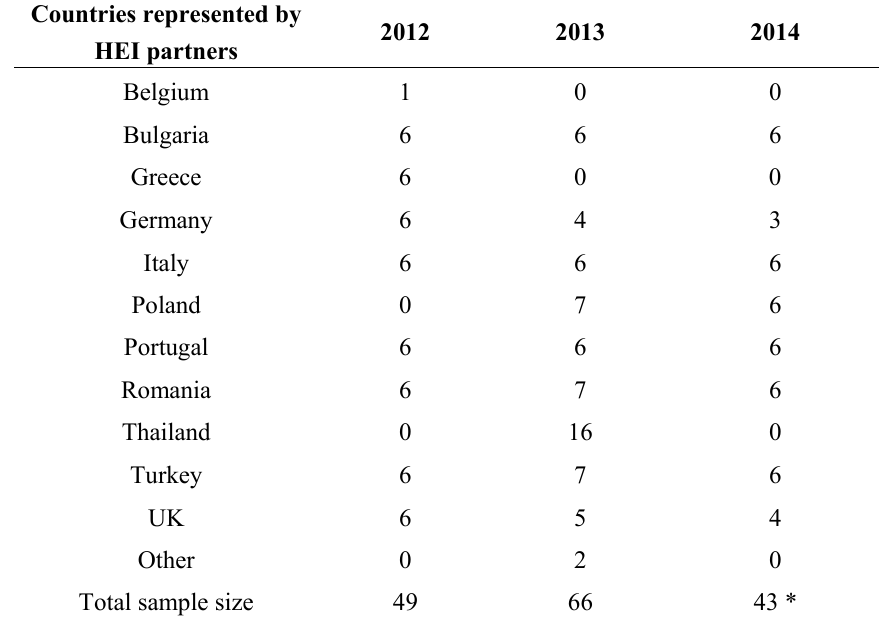
Table 1. Number of participants representing countries from HEI partners. Countries represented